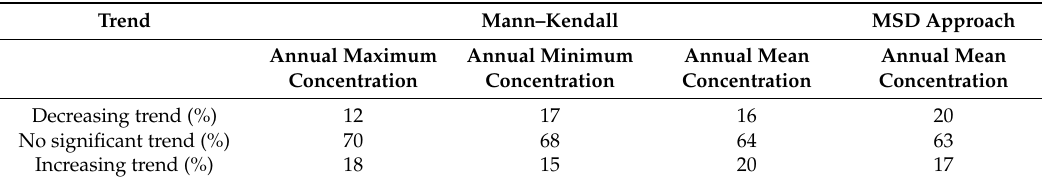
Table 3. Trend analysis of annual maximum, minimum and mean nitrate concentrations using the Mann– Kendall (columns 2–4) and Nitrates Directive methods (column 5) with the WQ366 dataset (raw